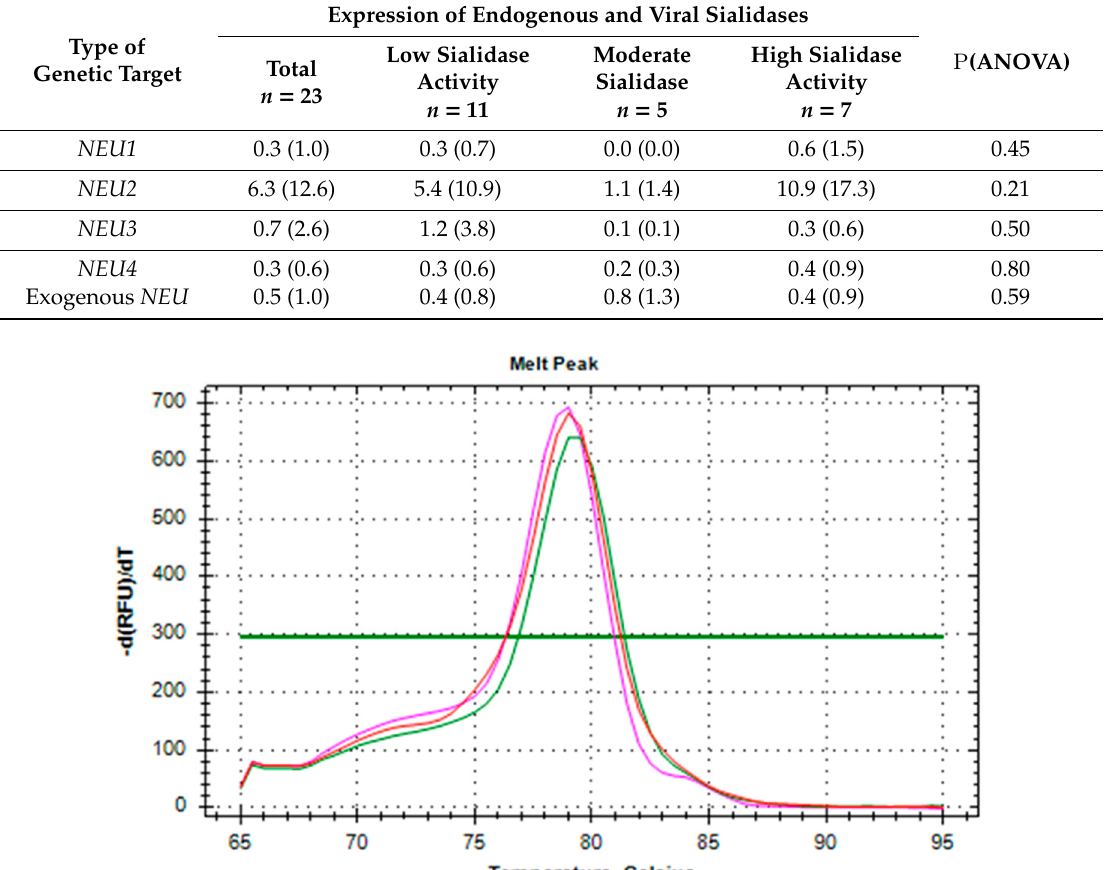
Table 2. Relative expression of endogenous and exogenous sialidases (presented as mean values with standard deviations).